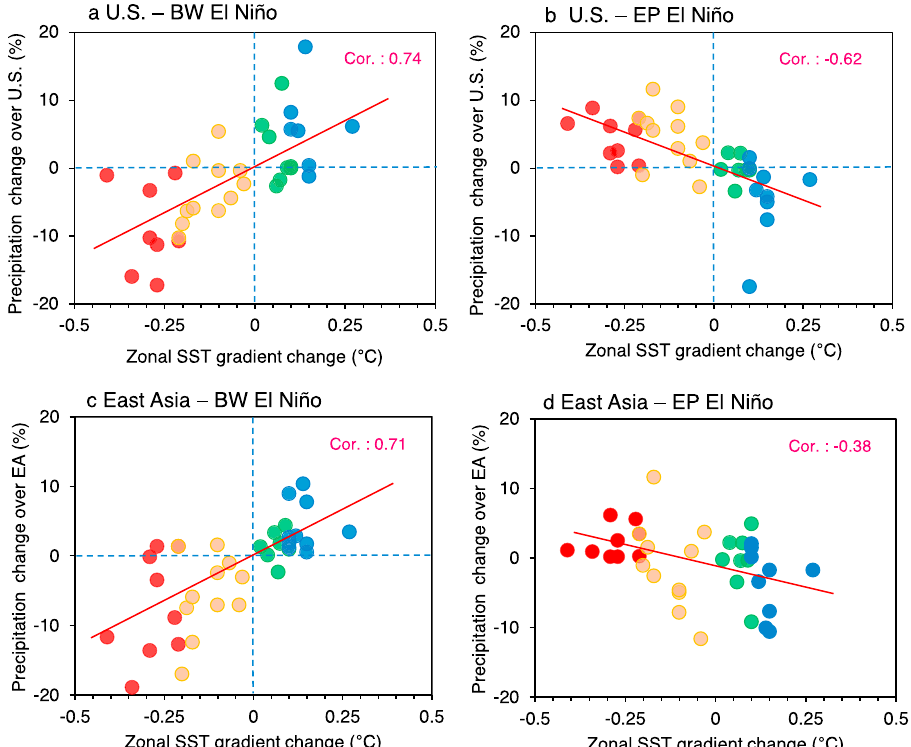
Fig. 5 Future precipitation changes associated with zonal SST gradient change. a , b Scatter plots between the changes in zonal sea surface temperature (SST) gradients over the equatorial Paci fi c ( x -axis, unit: °C) and boreal winter (October to February) precipitation changes ( y -axis, unit: %) over the central and eastern America (20°N – 35°N, 110°W – 75°W), induced by Basin-Wide (BW) and Eastern Paci fi c (EP) types of El Niño events. The zonal SST gradient is de fi ned as the SST difference between the western Paci fi c (5°S – 5°N, 150°E – 175°W) and eastern Paci fi c (5°S – 5°N, 115°W – 145°W). Eighteen climate models with two ensemble members were used. The change indicates the difference between historical (1943 – 1992) and Representative Concentration Pathway (RCP) 4.5 (or RCP 8.5) (2038 – 2087) scenarios. c , d Same as a , b , but for East Asia (EA, 25°N – 35°N, 110°E – 125°E). Red (blue) dots represent the models with El Niño-like (La Niña-like) mean SST change. The linear regression line is shown as the solid red line in each panel, with correlation coef fi cient. Red (orange) dots represent the models experiencing strong (weak) El Niño-like mean SST changes, while blue (green) dots indicate strong (weak) La Niña-like mean SST changes in the